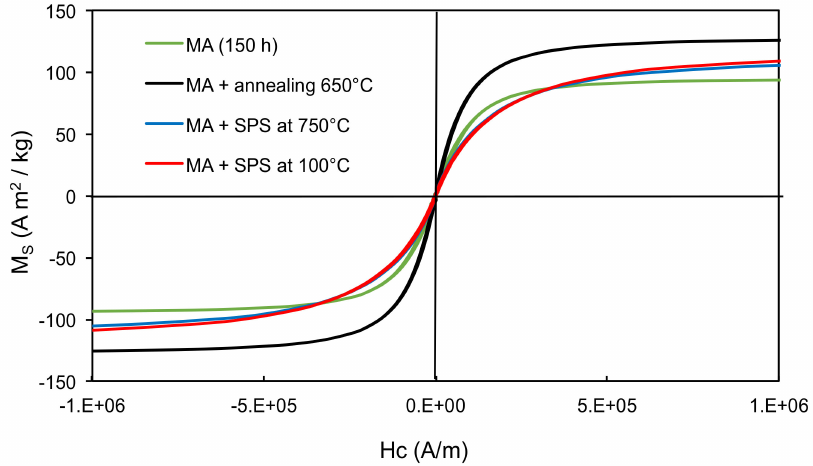
Figure 9. Magnetic hysteresis plots of 150-h milled FeCoNiB 0.5 Si 0.5 powders after annealing, MA + SPS at 750 ◦ C and MA + SPS at 1000 ◦